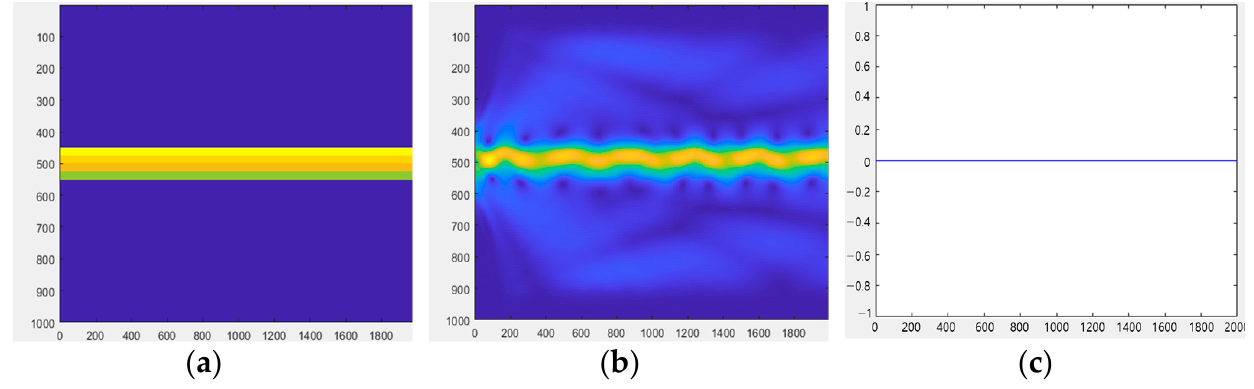
Figure 9. ( a ) Optical waveguide viewed from the side. ( b ) Scattering in the optical waveguide. ( c ) Optical waveguide.